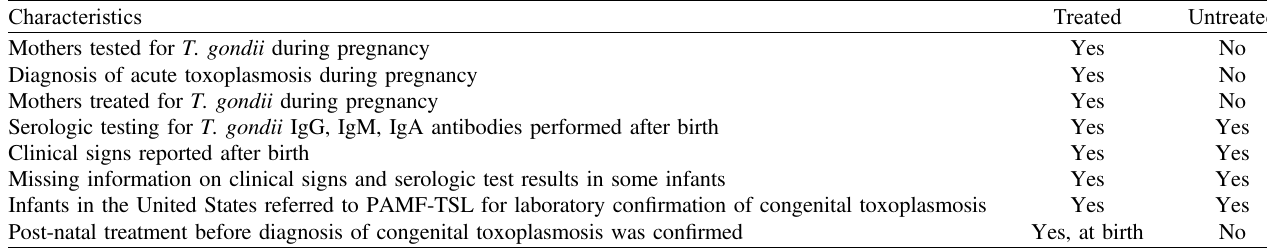
Table 1. Characteristics of infants with congenital toxoplasmosis born to treated and untreated mothers in the United States. Characteristics Mothers tested for T. gondii during pregnancy Diagnosis of acute toxoplasmosis during